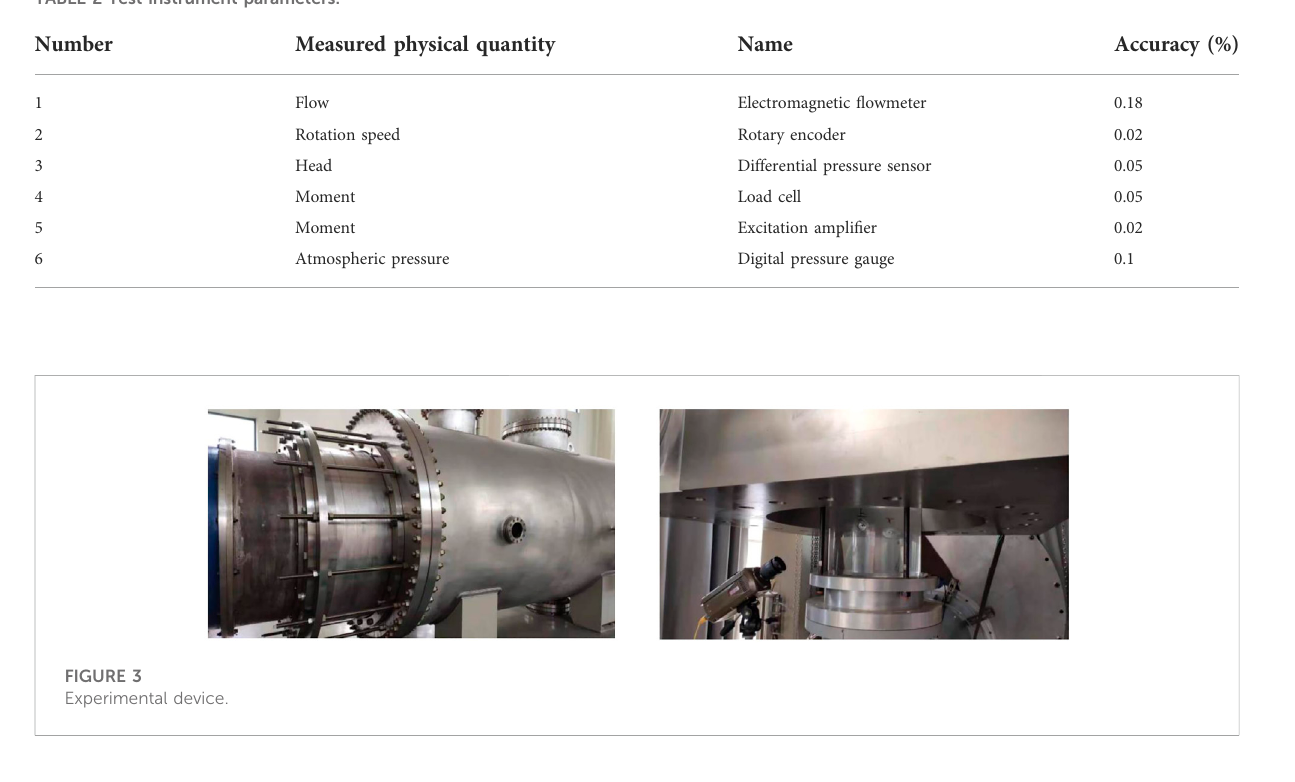
TABLE 2 Test instrument parameters.